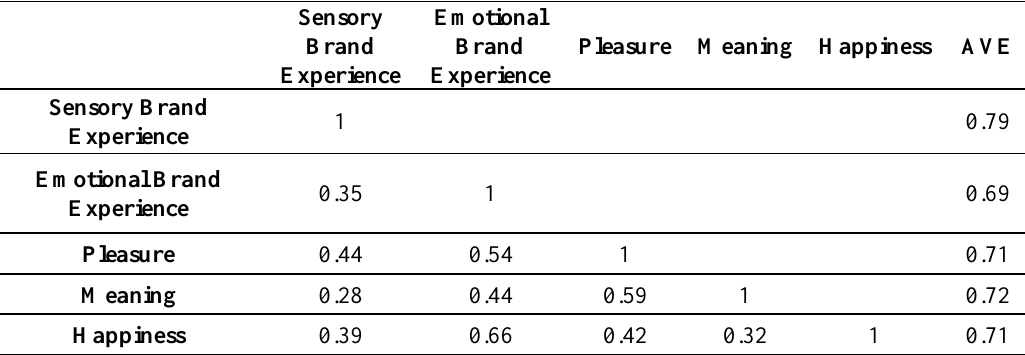
Table.4. The AVE and Squared Correlation Matrix